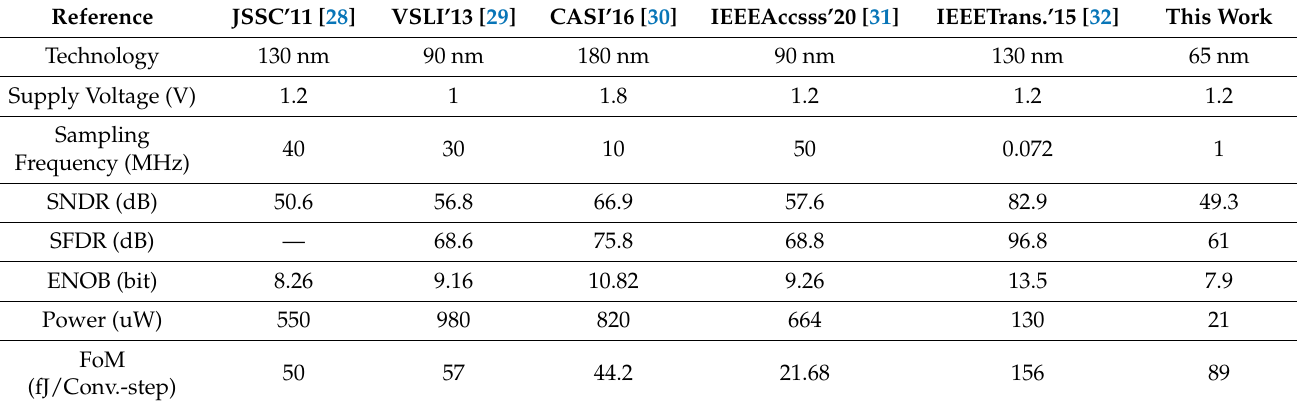
Figure 22. The fast Fourier transform (FFT) of the proposed SAR-ADC. Table 4. Performance summary and comparison with state-of-the-art